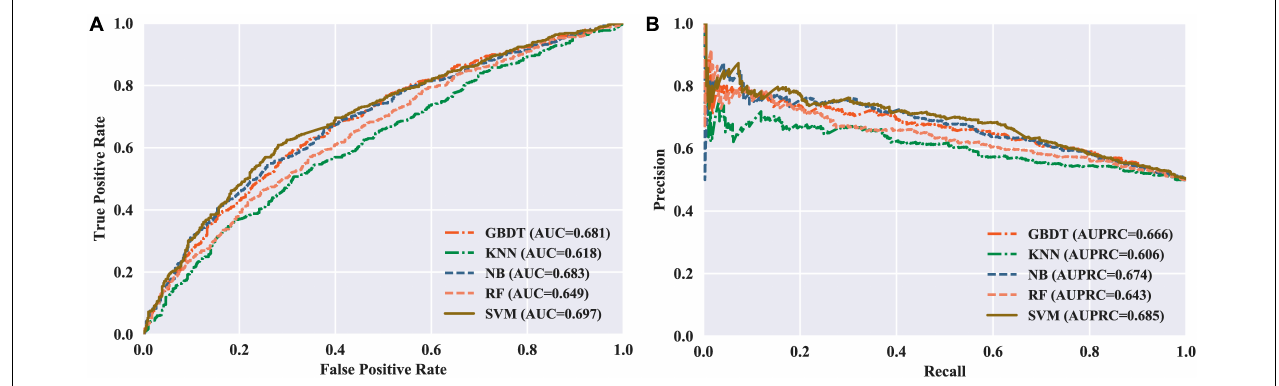
FIGURE 3 | Performance of different classifiers evaluated with five-fold cross validation. (A) ROC curves of different classifiers. (B) PR curves of different